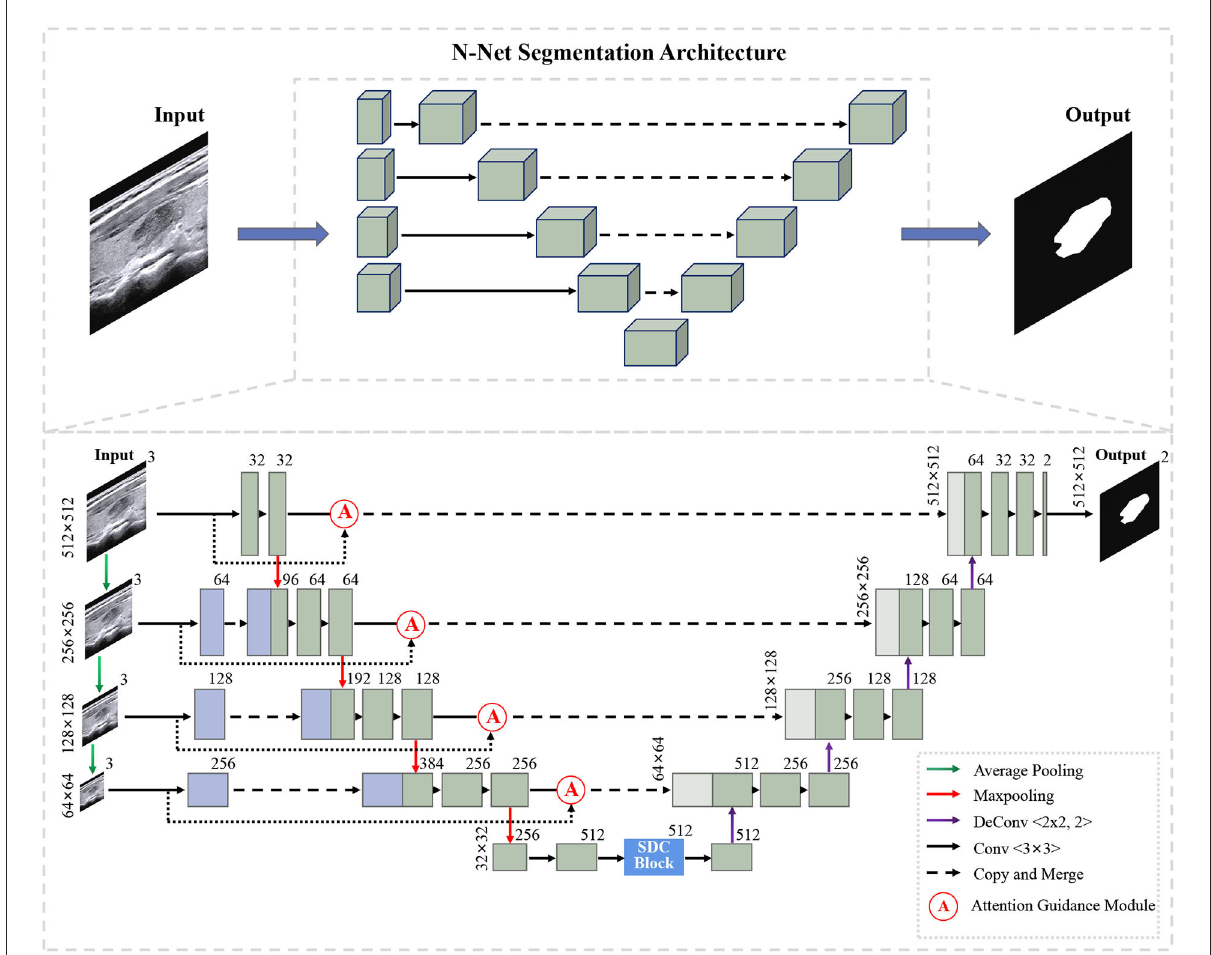
FIGURE1 Illustration of our N-Net segmentation